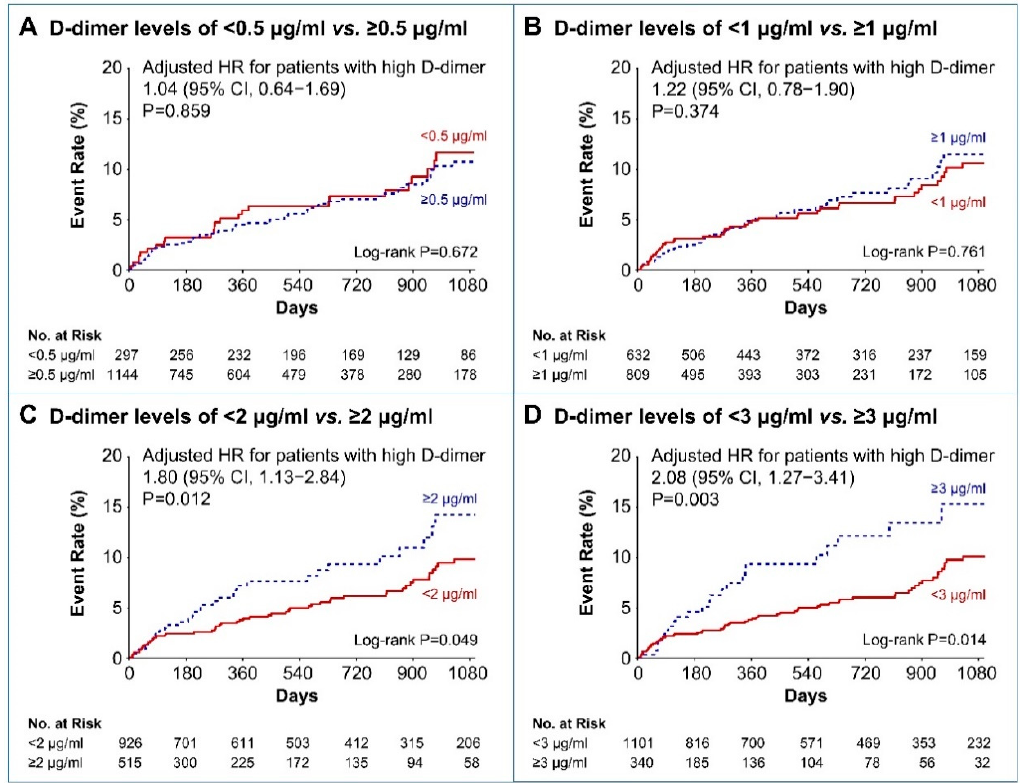
Figure 2. Kaplan–Meier curves and adjusted hazard ratios for recurrent ischemic stroke according to the baseline D-dimer levels. HR, hazard ratio; CI, confidence interval.